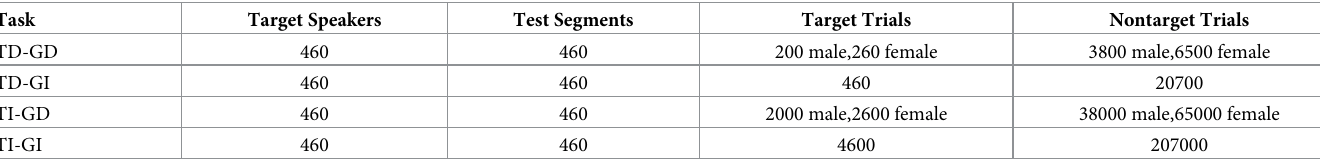
Table 2. Details of text-dependent and text-independent short-time ASV